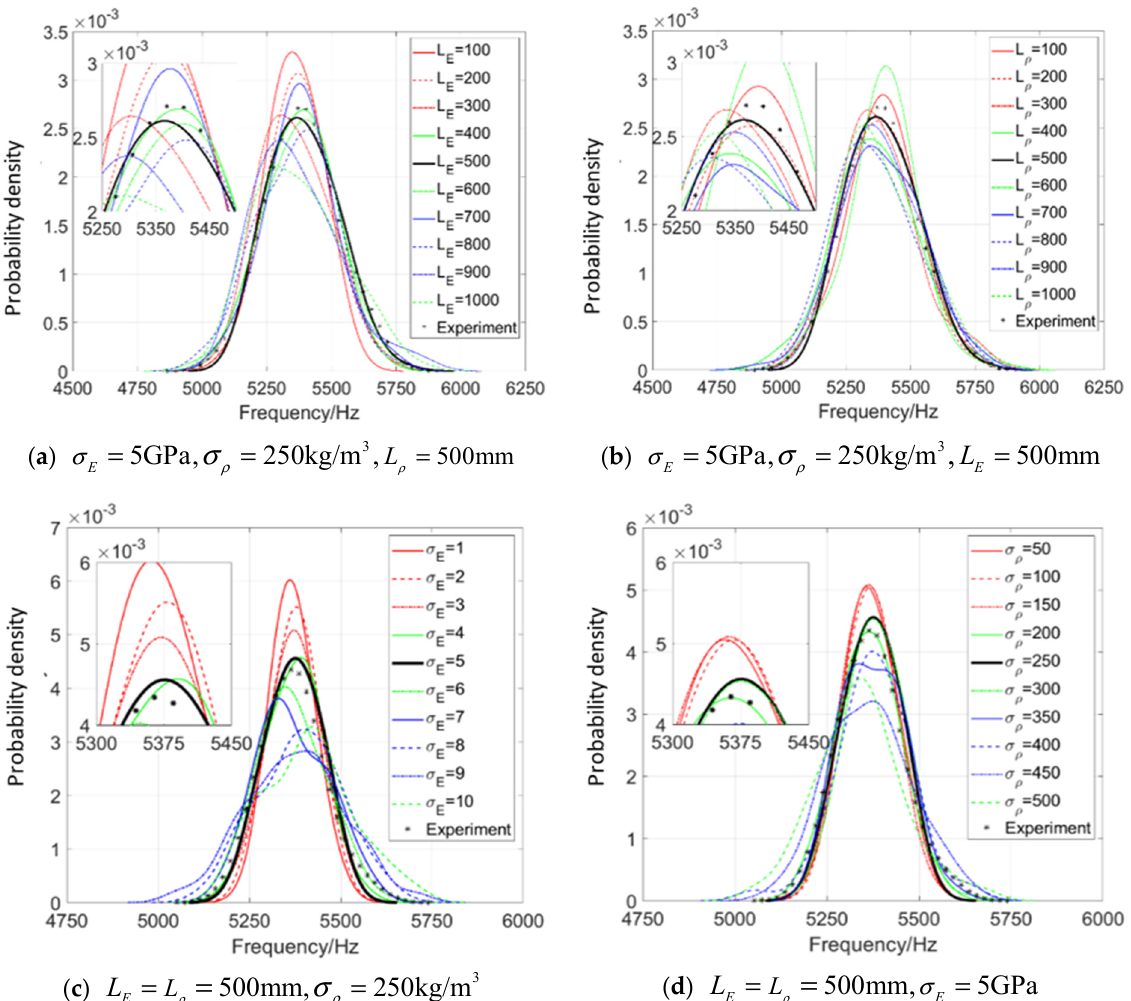
Figure 6. One-dimensional kernel density estimation of the second-order natural frequency when considering random fields E and